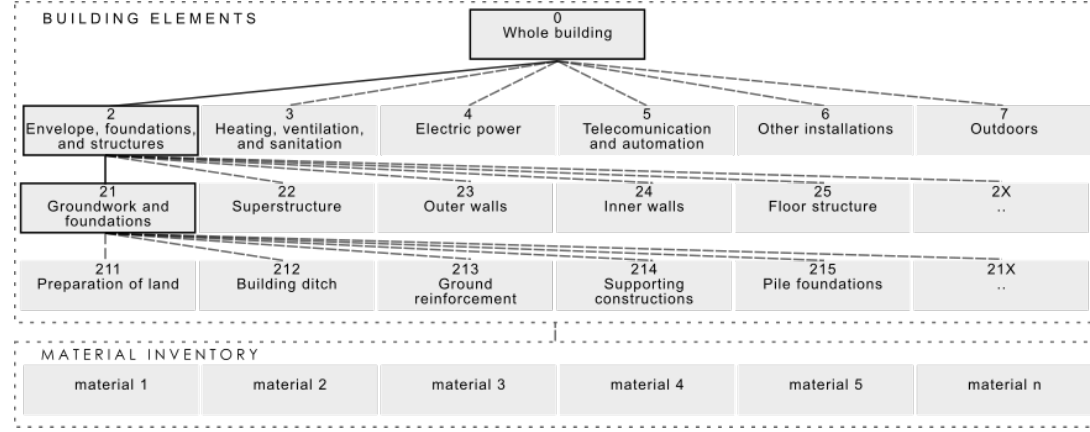
Figure 2. The hierarchical structure of the building elements according to NS 3451, and the material inventory. The elements with bold outlines are expanded to show their sub-elements. Each building element has its level ID above its name. The inventory items are connected to specified building elements.